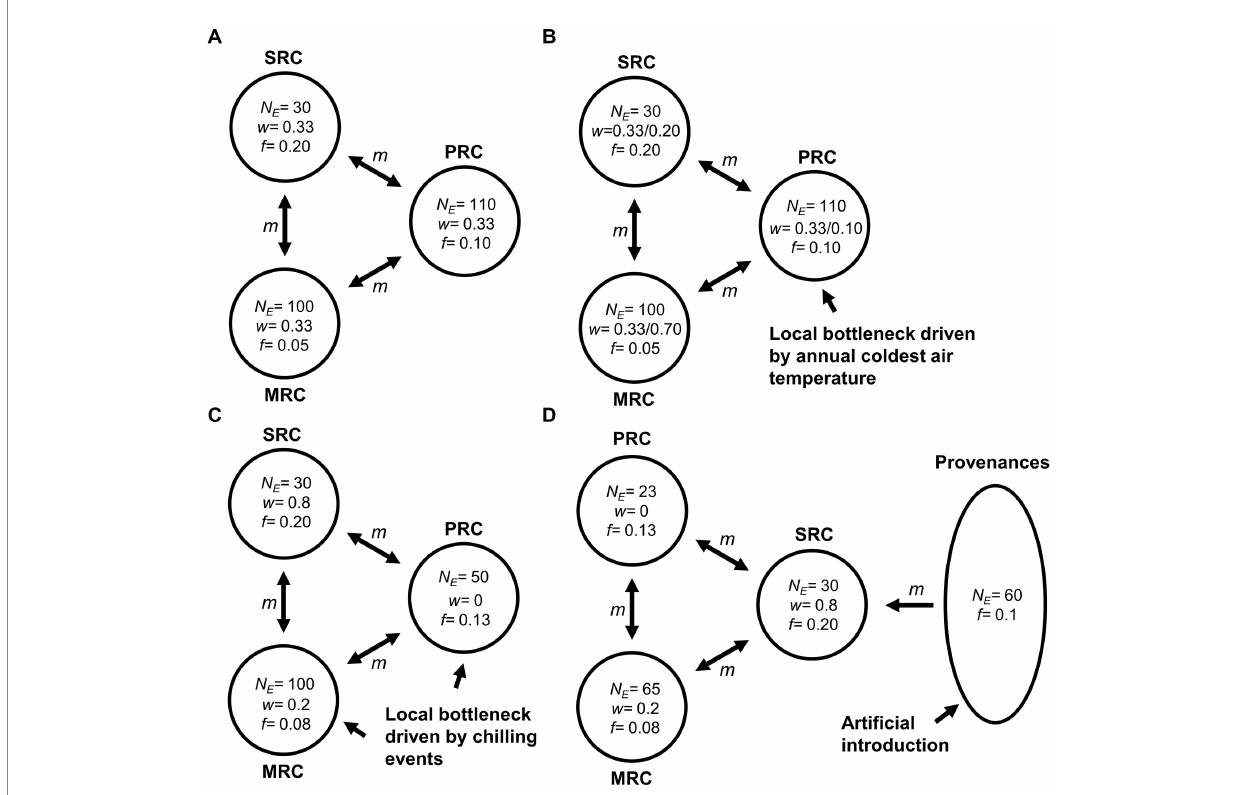
FIGURE 2 Schematic diagram of the Yueqing metapopulation of Kandelia obovata used for modeling changes in N E . We assume a metapopulation comprising three subpopulations and simulate four scenarios: (A) Scenario I: the effects of low temperature on each subpopulation are disregarded; (B) Scenario II: the subpopulation with poor cold resistance undergoes a local bottleneck induced by the annual coldest air temperature; (C) Scenario III: the subpopulations with moderate and poor cold resistance undergo local bottlenecks caused by extreme low-temperature events; and (D) Scenario IV: individuals from higher-latitude populations are introduced after extreme low-temperature events. SRC: group with strong resistance to cold; MRC: group with moderate resistance to cold; and PRC: group with poor resistance to cold. The values of N E and inbreeding levels ( f ) of each subpopulation under different scenarios are based on empirical estimates in Geng et al. (2021) and our results. Bidirectional gene flow between different subpopulations is indicated by two-headed arrows, and m indicates the strength of gene flow. Subpopulation weights ( w ) indicate the reproductive contributions of the different subpopulations, and subpopulation weight values are set based on the results of the parental analysis. In Scenario II, we consider two situations separately. One of them is the three subpopulations have the same reproductive contributions ( w = 0.33), which is referred to as Scenario II in the subsequent result and discussion. The other one is the three subpopulations possess different reproductive contributions, and we set different w for them (SRC = 0.2; MRC = 0.7; PRC = 0.1), which is called Scenario II different w